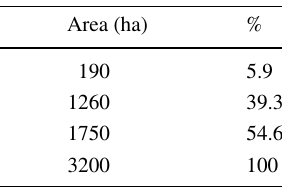
Table 1 Average hydraulic conductivity with Thiessen method